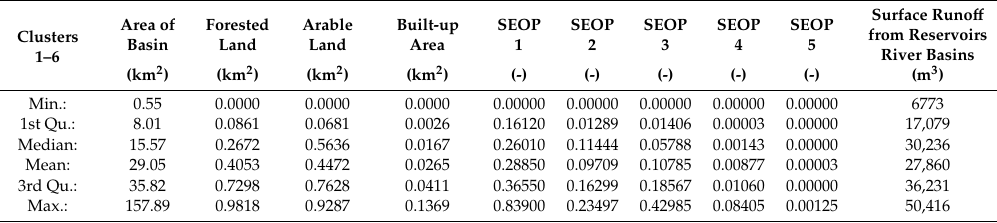
Table 2. Overall data characteristics of individual